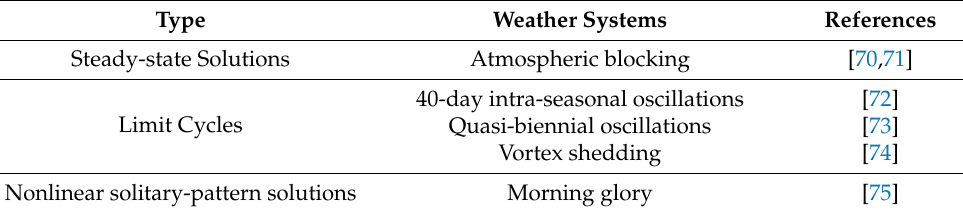
Table 2. Non-chaotic Solutions vs. Weather